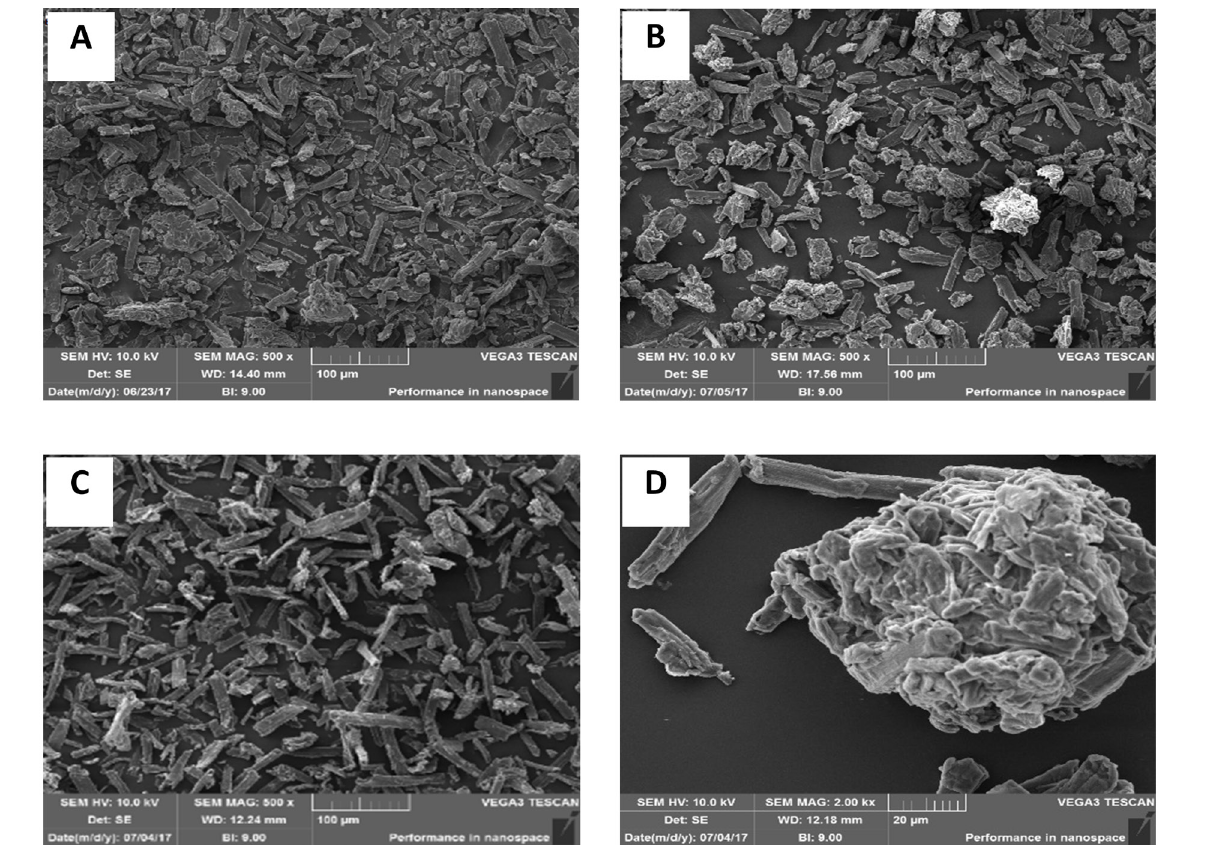
Figure 1: SEM image of hydrolyzed cellulose under different waste liquid cycles (a) uncycled (single passage), (b) recycled three times, (c) recycled five times, (d) an example of an agglomerated